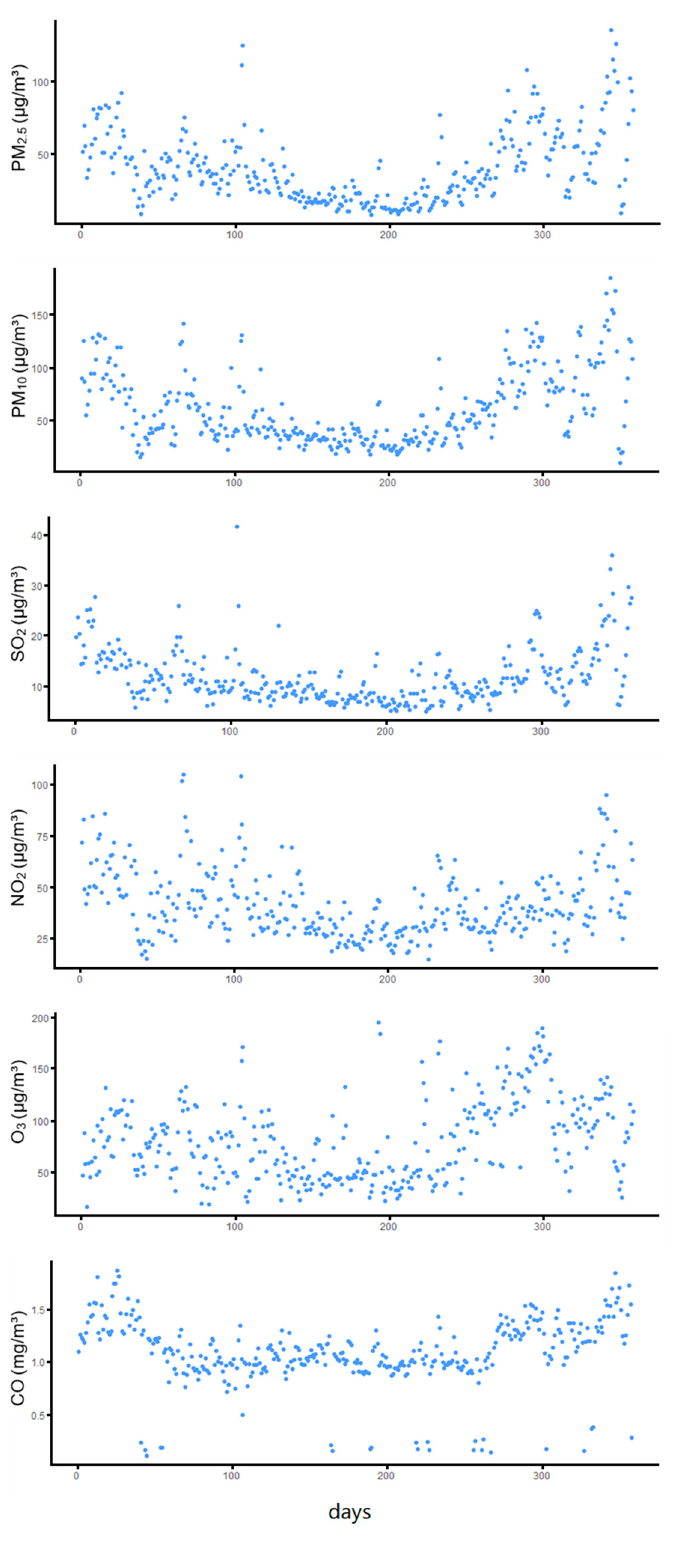
Figure 2. Air pollutant concentration-time scatters